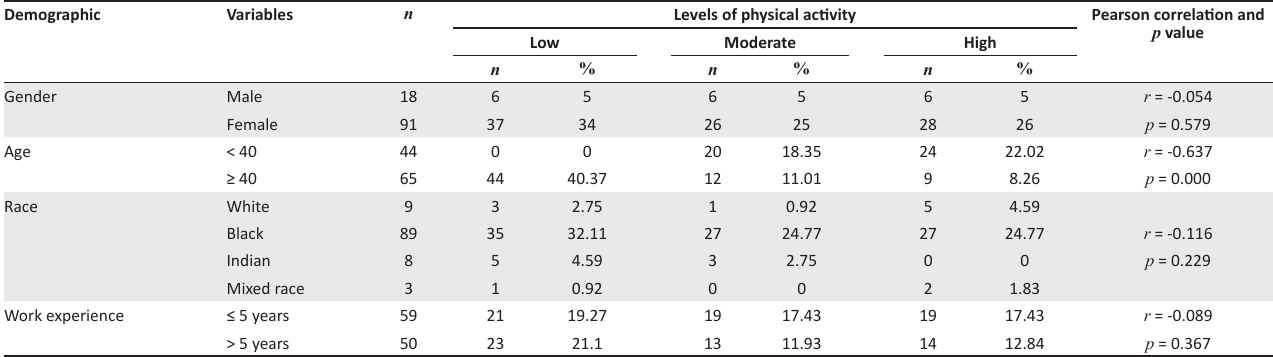
TABLE 4: Correlation between demographics and levels of physical activity. Demographic Variables n Levels of physical activity Pearson correlation and